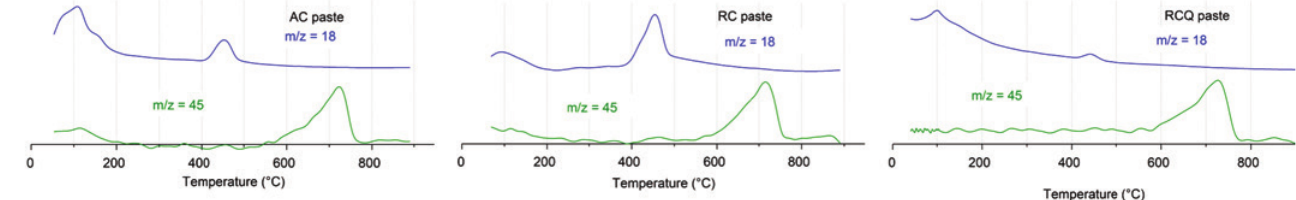
Volatile products released by pastes produced with anhydrous Portland cement (AC); recycled cement (RC), and 15% replacement by sand powder